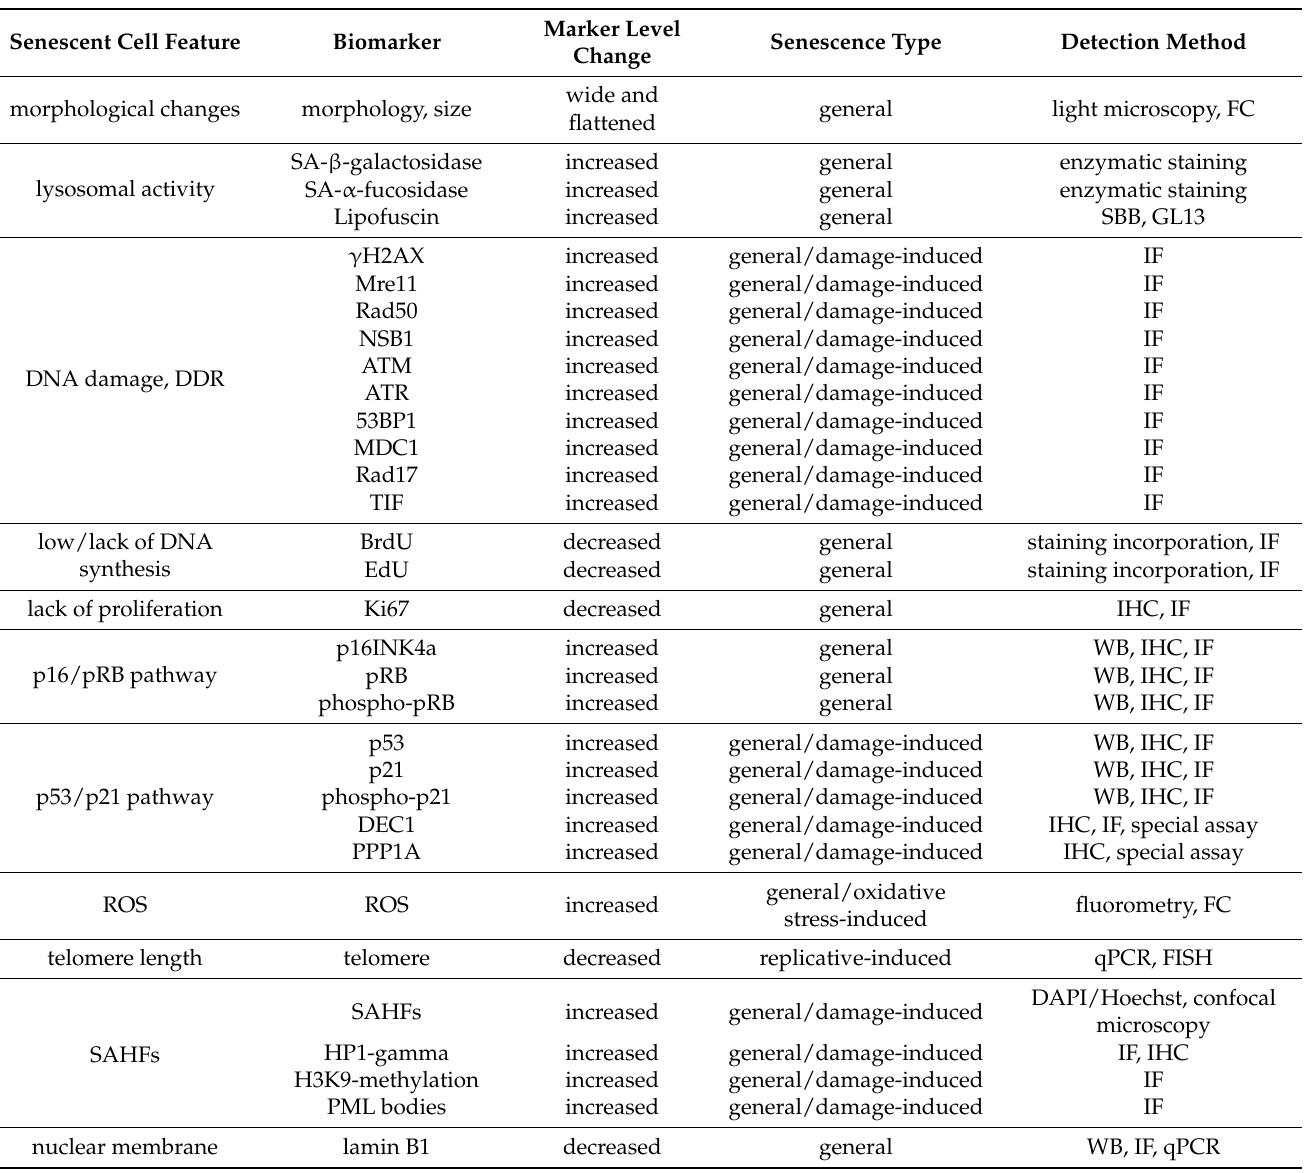
Table 1. Notable senescence markers and methods used for their